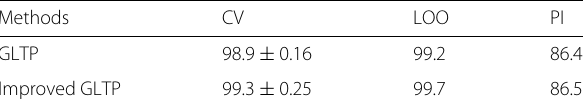
Table 1 Recognition rate (%) for 6-class emotion in CK+ dataset using GLTP and Improved GLTP